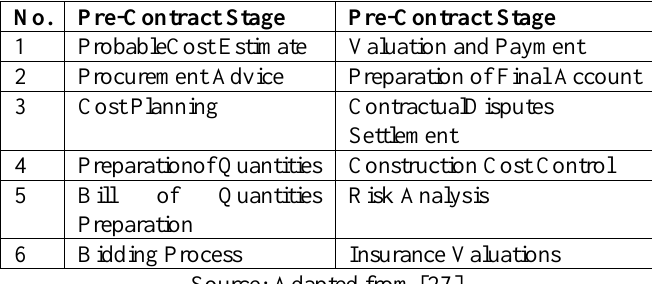
Table 1: QS's Roles in Cost Management in